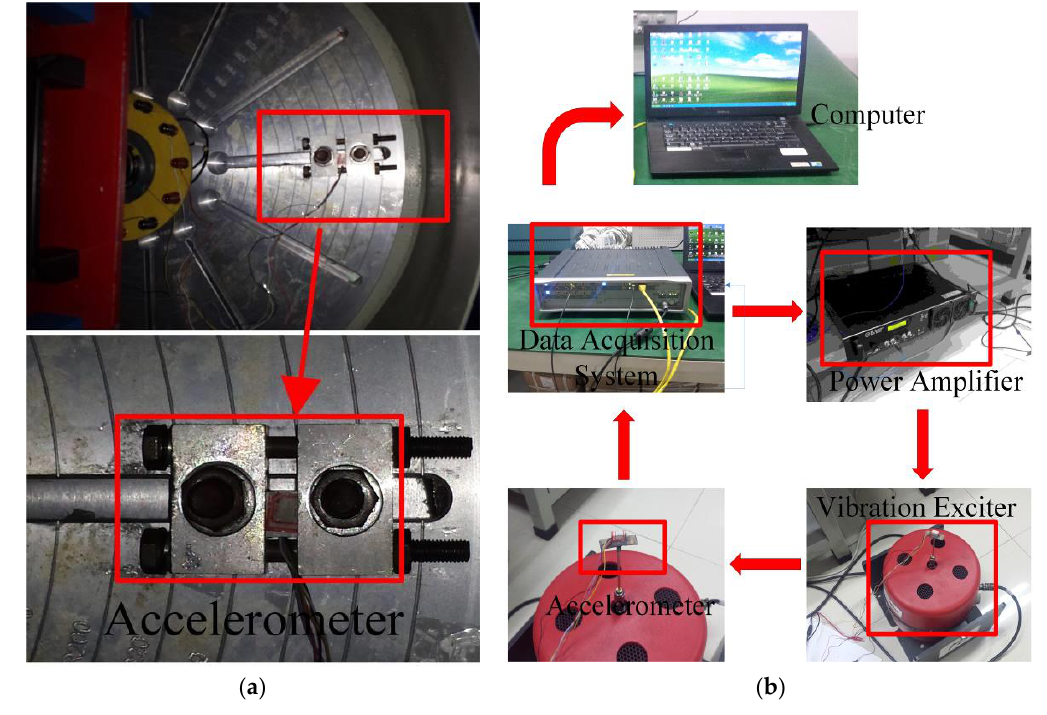
Figure 8. The experiment setups ( a ) The static experiment ( b ) The dynamic experiment.